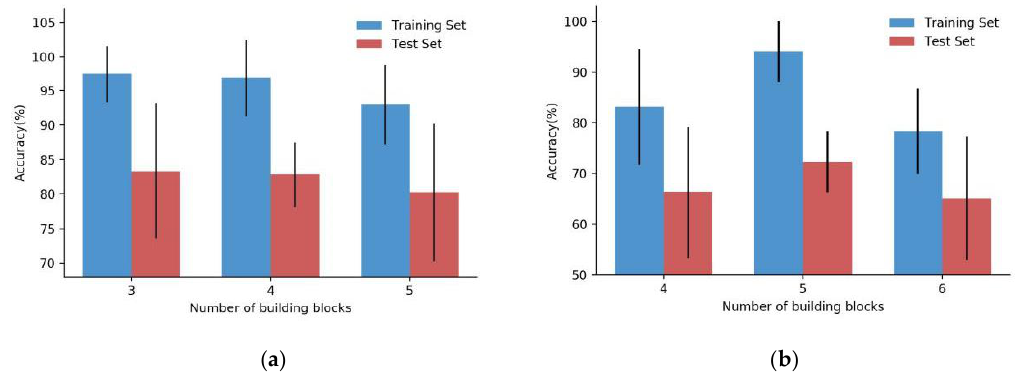
Figure 15. Comparison of accuracy with different numbers of building blocks by LCCDNNs. ( a ) C. elegans dataset, ( b ) zebrafish dataset.